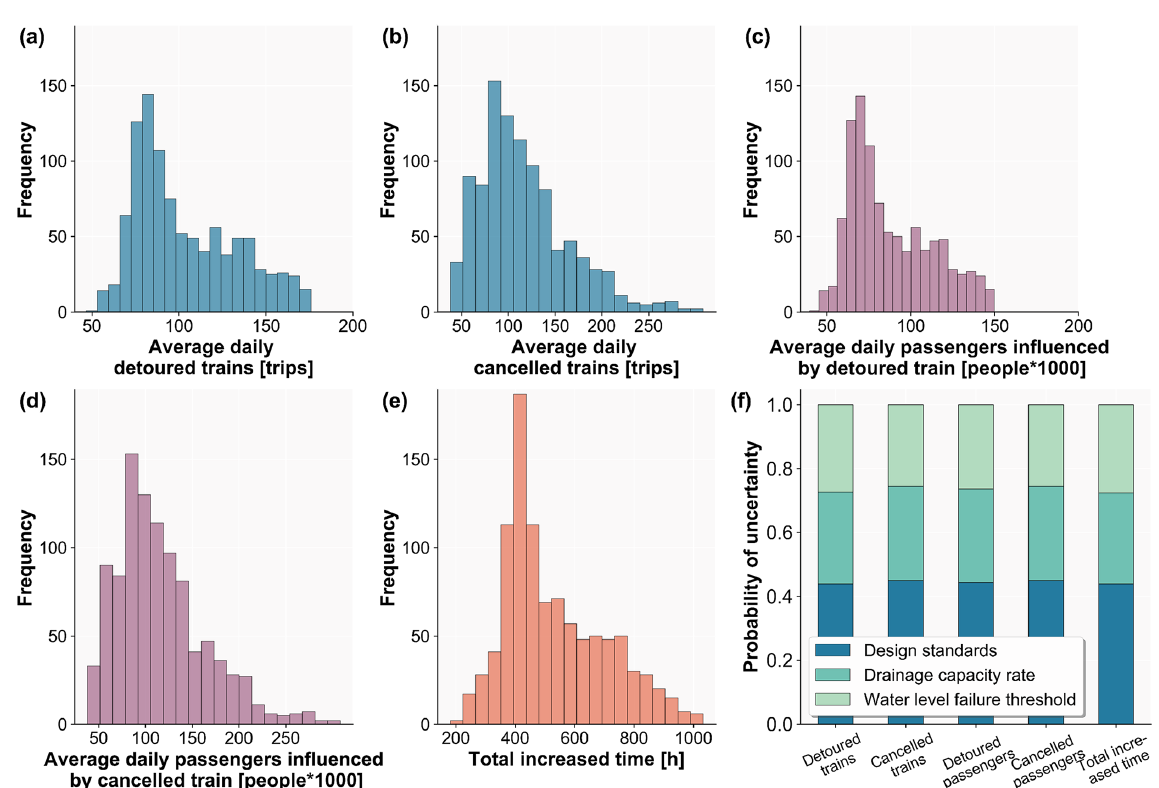
Figure A7. Results of the uncertainty and sensitivity analyses for the performance metrics. (a) Average daily detoured trains; (b) average daily cancelled trains; (c) average daily passengers influenced by detoured trains; (d) average daily passengers influenced by cancelled trains; (e) total increased time; (f) the sensitivity